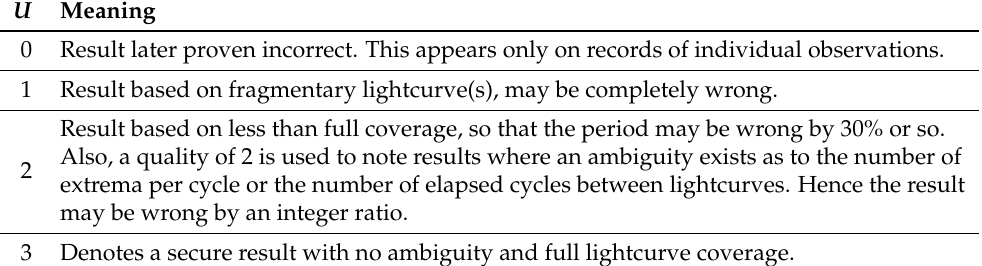
Table 2. The current-day U code assignment criteria